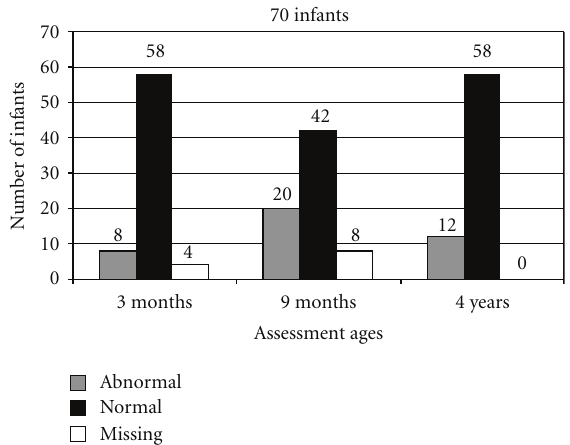
Figure 1: Motor developmental scores of patients at di ff erent corrected